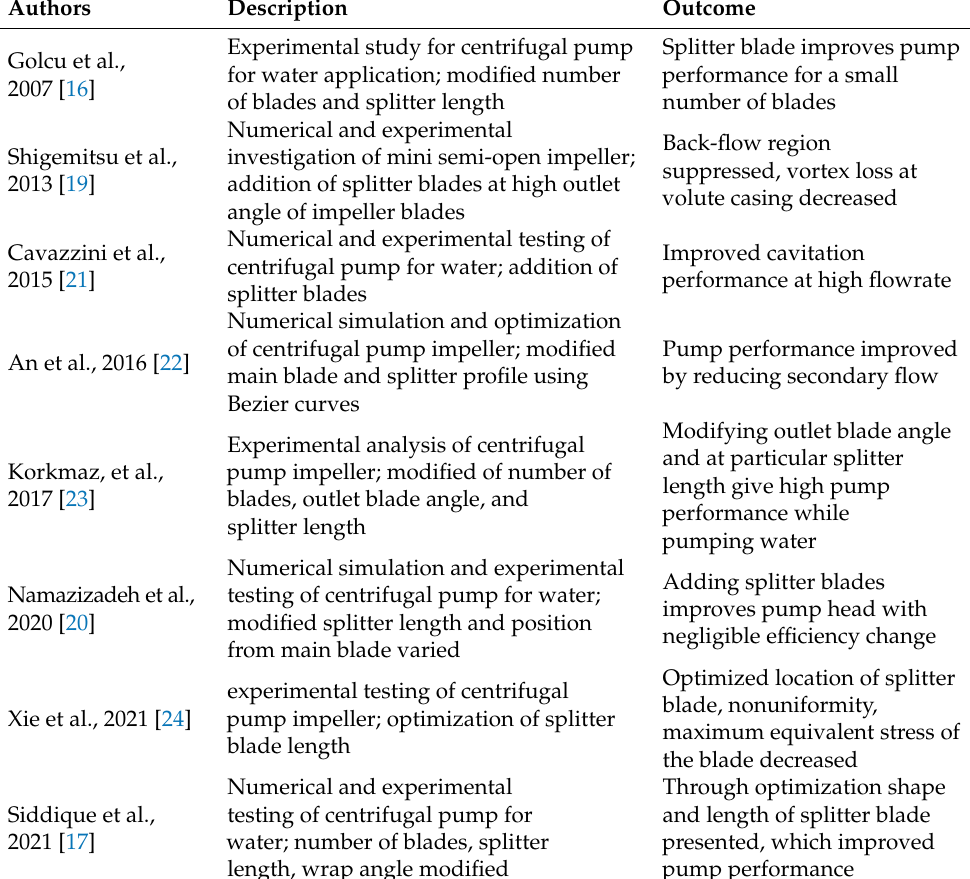
Table 1. Study of splitter blades in a centrifugal